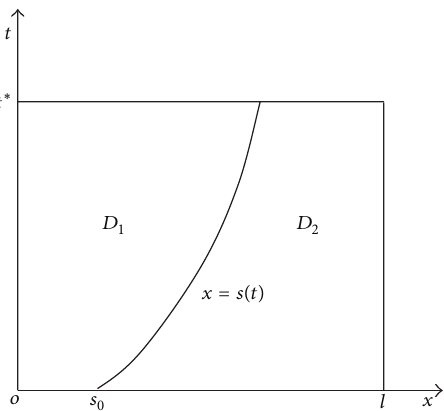
Figure 1: The domains of 𝑢 = 𝑢(𝑥,𝑡) and V = V (𝑥, 𝑡) and the position of the moving boundary 𝑥 = 𝑠(𝑡) in the